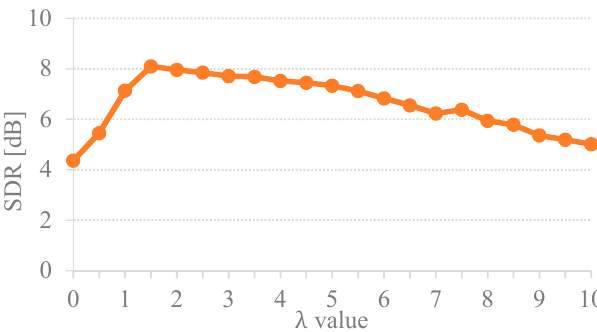
ff erent uniform